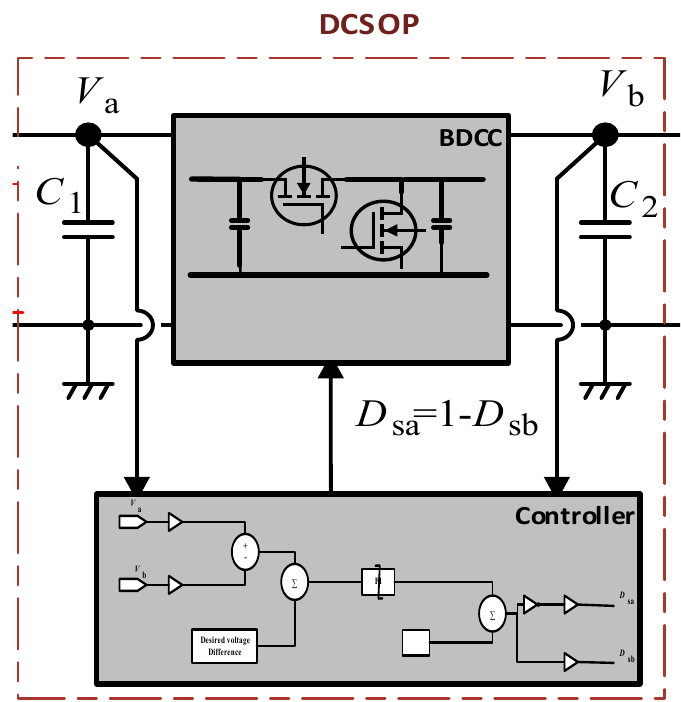
Figure 1. DCSOP based the virtual conductor.